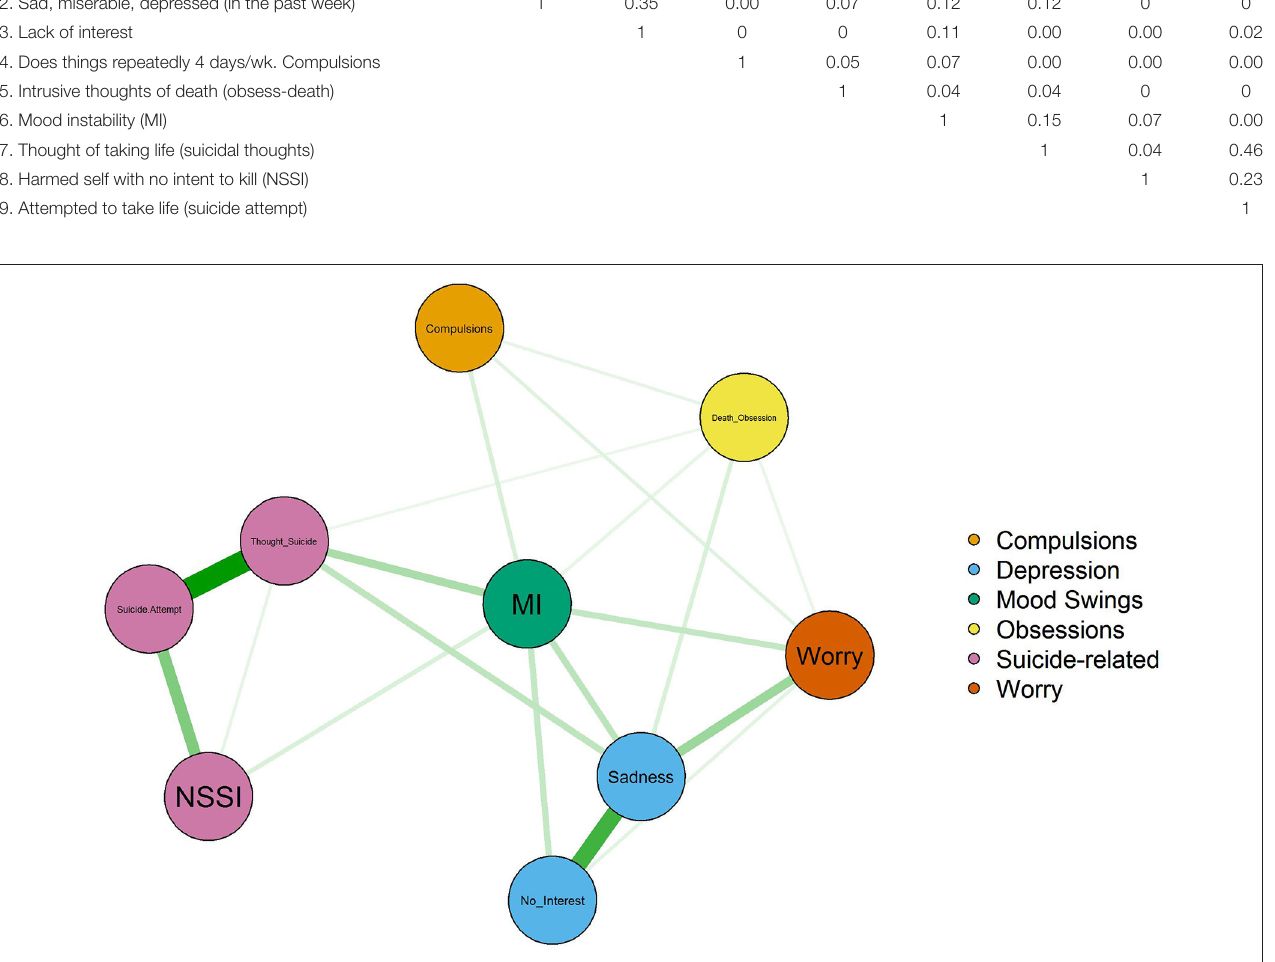
FIGURE 1 | Network model of suicidal outcomes and mood